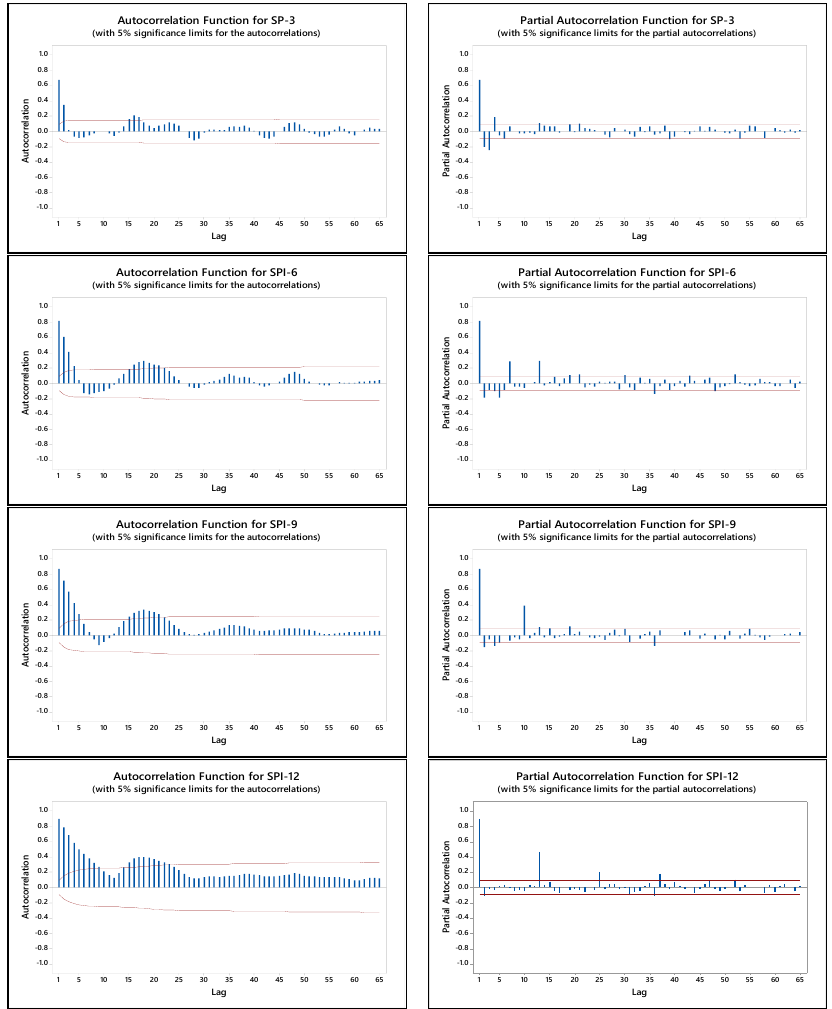
Figure 6. Autocorrelation and partial autocorrelation function for SPI across different timeframes.